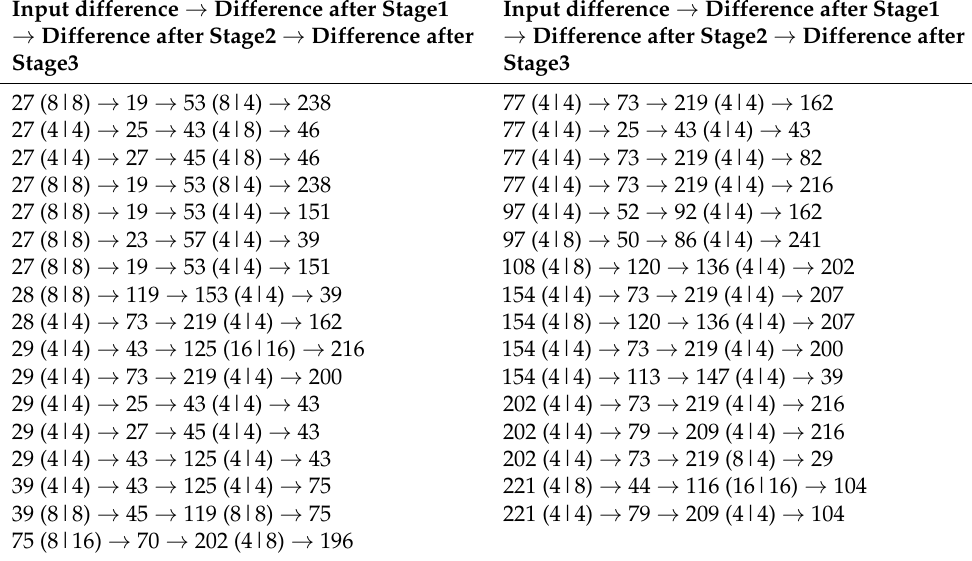
Table 8. Found chains for difference transformation in